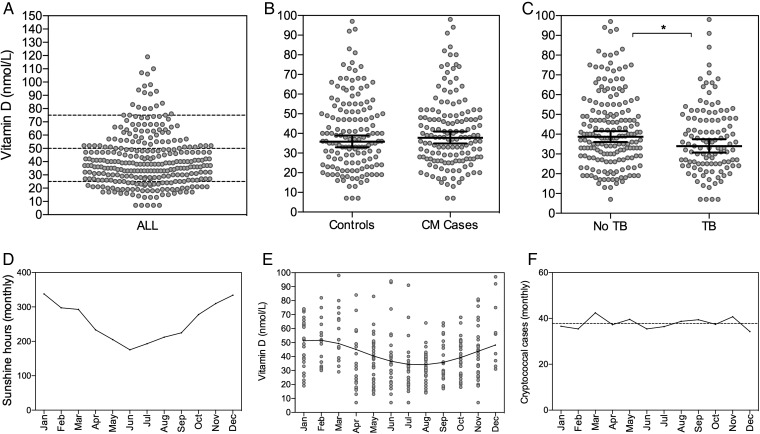
Plasma 25-hydroxyvitamin D (25[OH]D) levels by cryptococcal meningitis status, tuberculosis status, and season. A, Plasma 25(OH)D levels of the whole study population (cases and controls combined), with dashed lines at 75 nmol/L (vitamin D insufficiency), 50 nmol/L (vitamin D deficiency), and 25 nmol/L (severe vitamin D deficiency). B and C, Plasma 25(OH)D levels according to cryptococcal meningitis case status (B) and tuberculosis status (C), with lines at the geometric mean and error bars showing 95% confidence intervals. Levels of 25(OH)D were significantly lower in individuals with tuberculosis than in those without tuberculosis (*34 nmol/L vs 39 nmol/L; P = .029). D, Average number of sunshine hours per month in Cape Town (source: National Oceanic and Atmospheric Administration, available at: www.noaa.gov). E, Levels of 25(OH)D by month (averaged over the 5-year study period) with cosinor regression line. F, Monthly cryptococcal notification rates (averaged over the period 2005–2011) with best-fit regression line. Abbreviations: CM, cryptococcal meningitis; TB, tuberculosis.